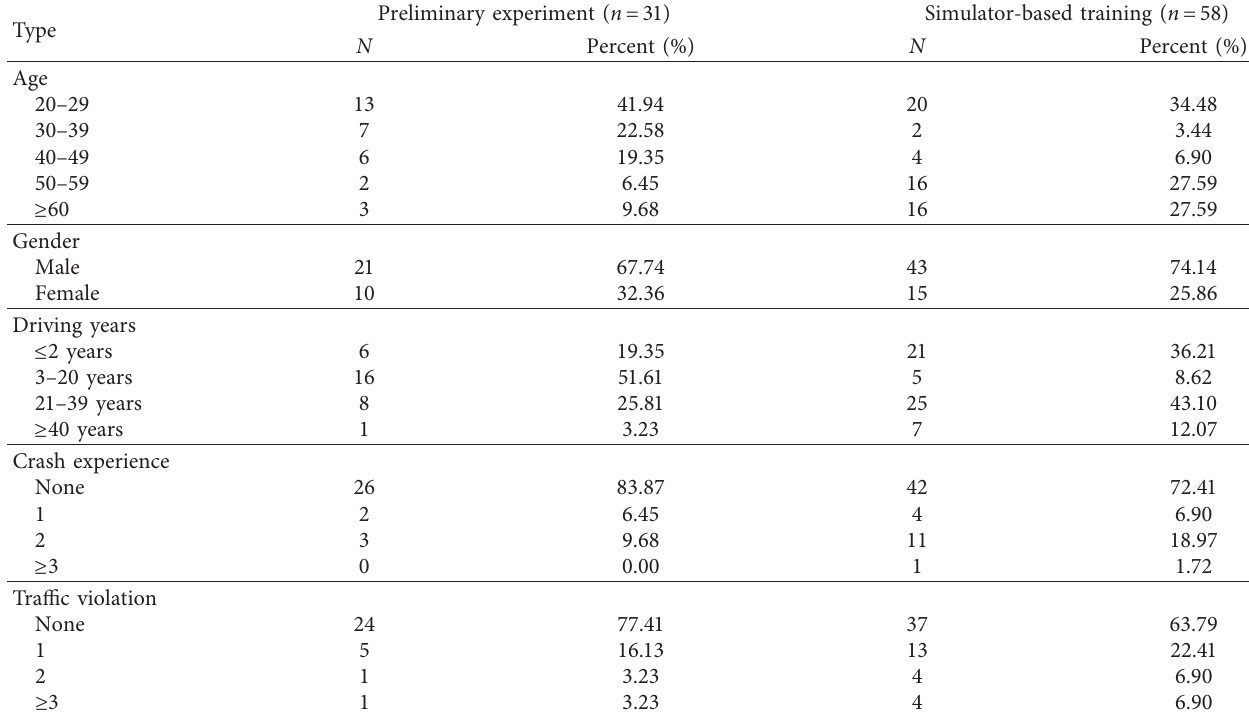
Table 2: Demographics of the participants in this